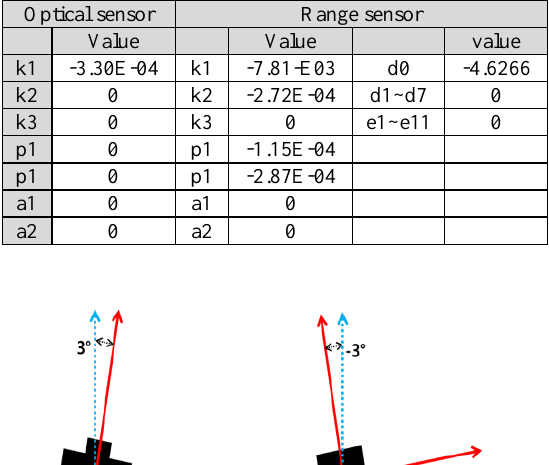
Table 4. Distortion parameters of optical and range sensors Optical sensor